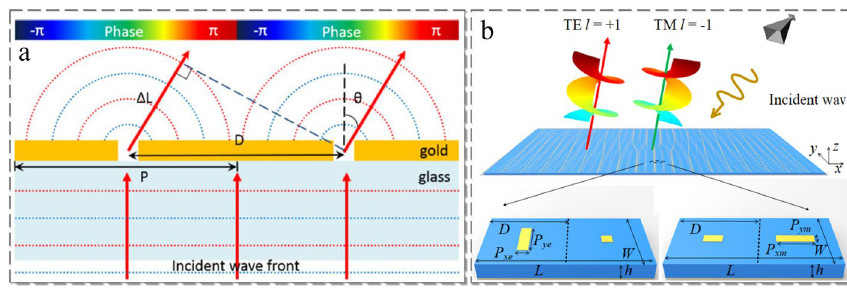
Fig. 4 a Principle of the detour phase. b Schematic of the detour phase metasurface for dual-polarized vortex beam generation. a Reproduced with permission [129]. Copyright 2016, Wiley-VCH. b Reproduced with permission [130]. Copyright 2022,